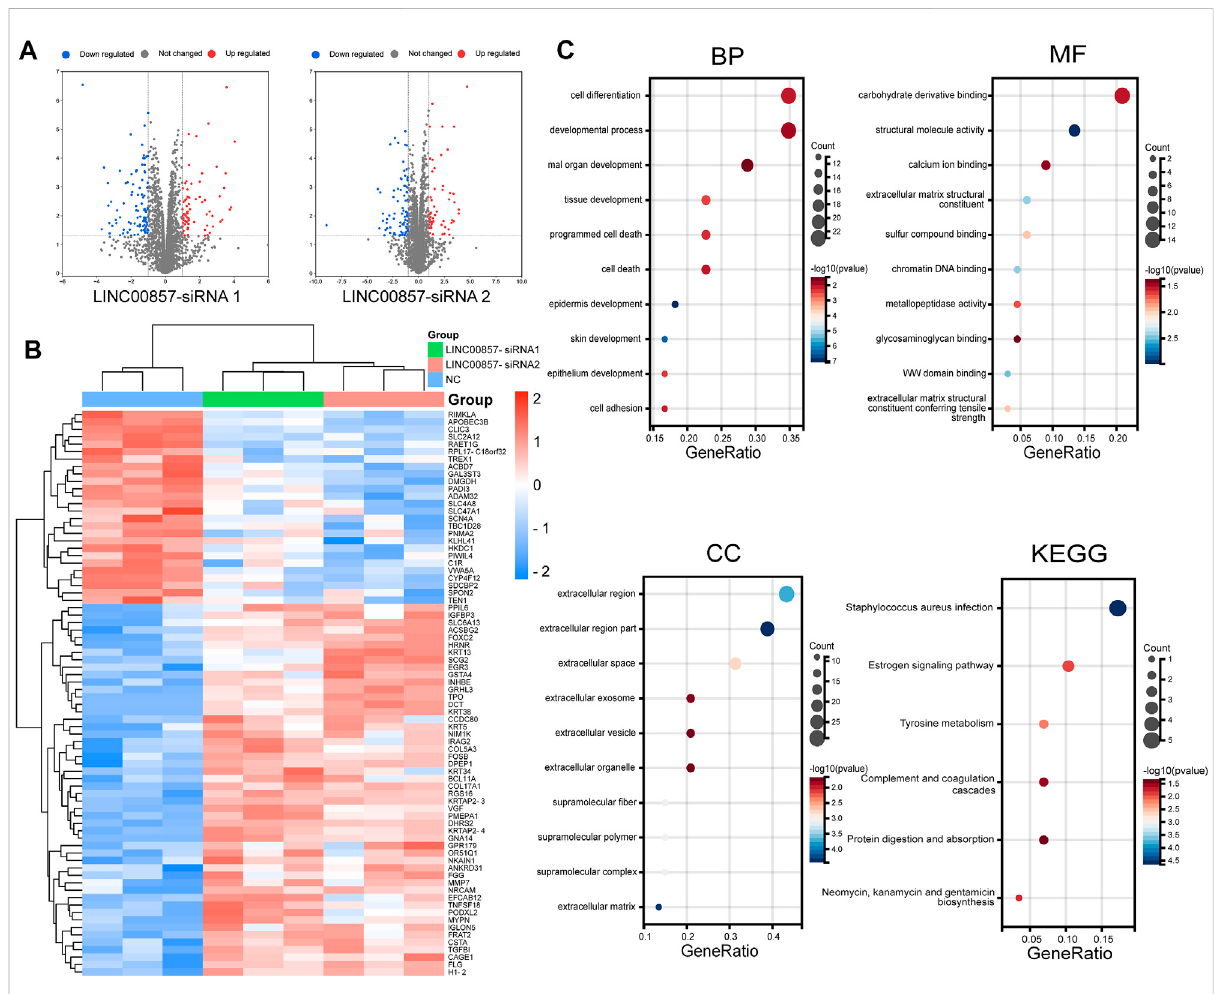
Transcriptomic landscape after LINC00857 silencing. (A) Volcano map depicted the distribution characteristics of all differential genes. ( p < 0.05,